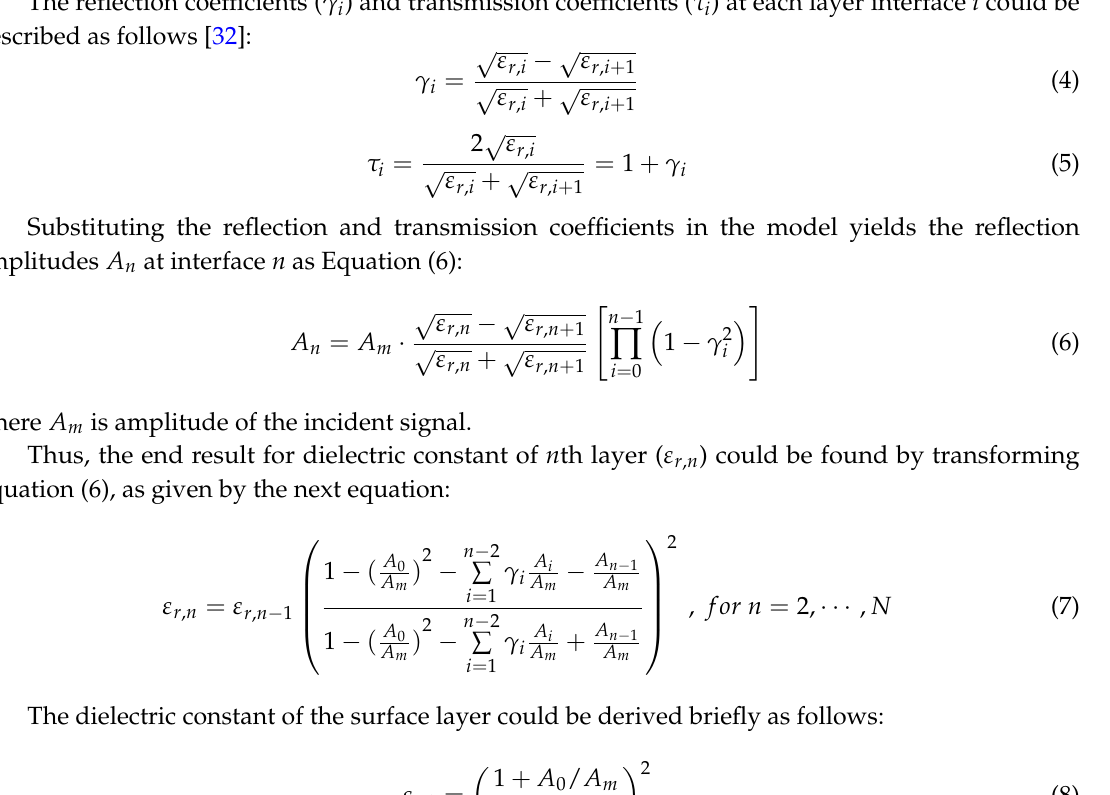
Figure 6. The planar layer model of asphalt pavements. ε r , i , σ i , d i are, respectively, the permittivity, conductivity and thickness at layer i , γ i and τ i are reflection and transmission coefficient at layer interface i .